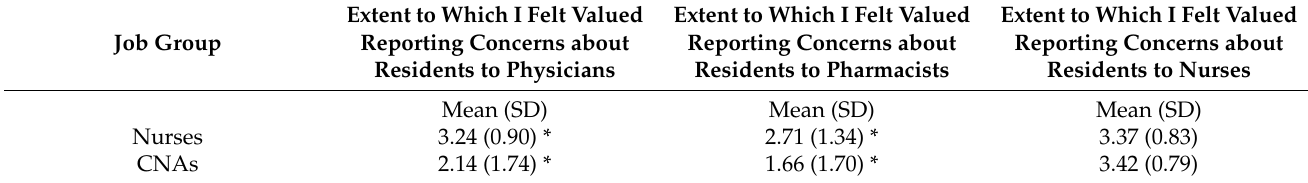
Table 2. Nurses and CNAs’ Perceived Sense of Value when Reporting to Physicians, Pharmacists, and